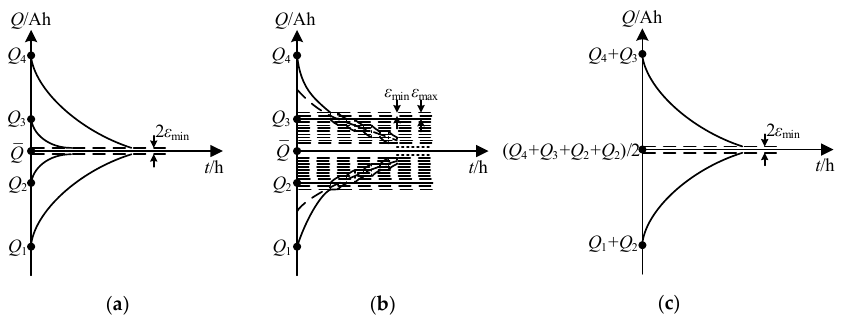
Figure 8. Equalisation processes of the inductor-based equalisation schemes. ( a ) The simplified equalisation scheme. ( b ) The series-based equalisation scheme. ( c ) The layer-based equalisation scheme.